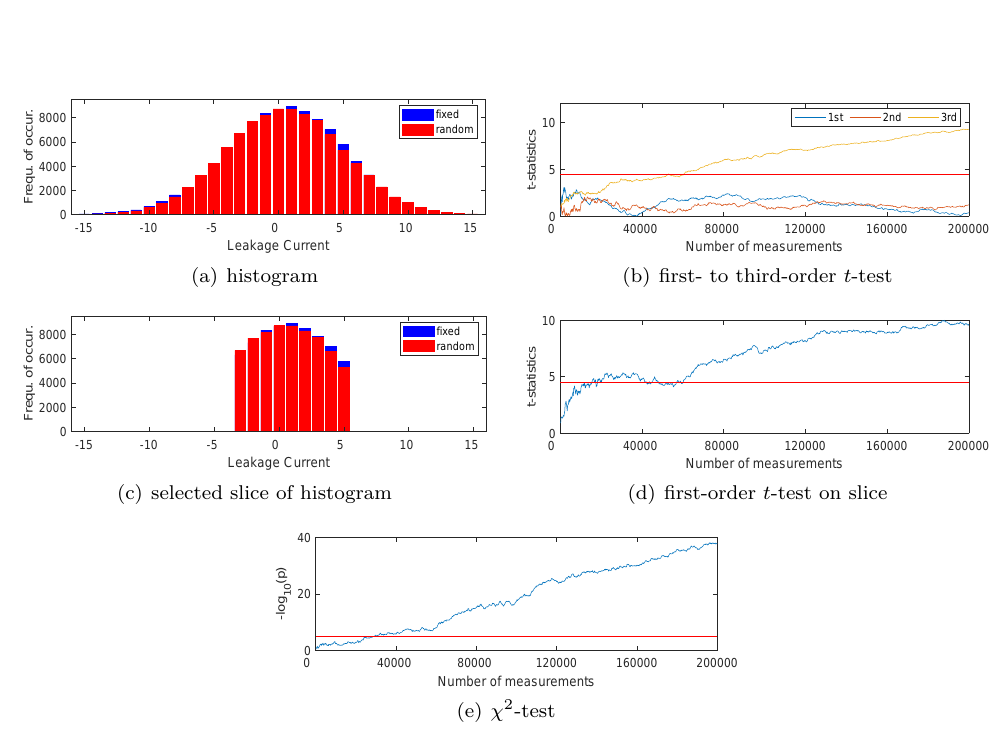
Figure 17: Same experiments as in Figure 15, but with only 200,000 traces and running the LFSR-based PRNG, responsible for delivering the fresh randomness, during the measurements to minimize algorithmic noise.